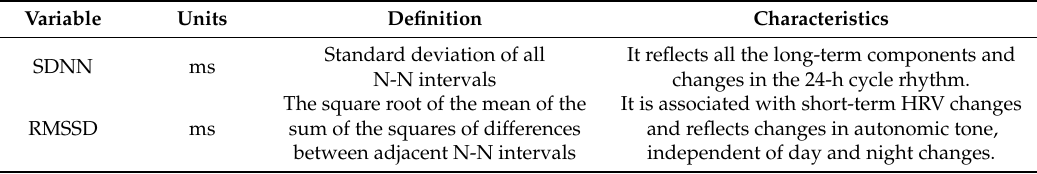
Table 1. Time-domain parameters of the HRV